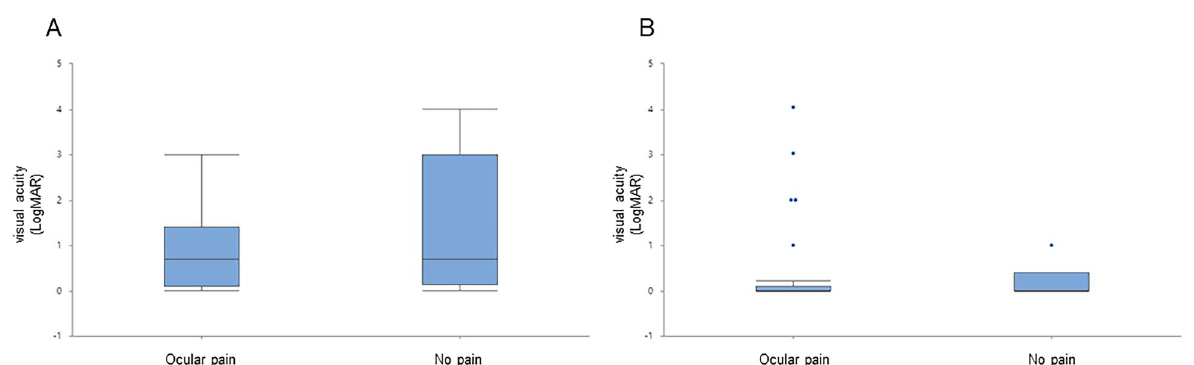
Figure 3. Visual acuity depending on the presence of ocular pain. ( A ) Visual acuity at initial visit (ocular pain group; 0.93 ± 0.13 and normal group; 1.30 ± 0.40) ( p = .282). ( B ) Visual acuity at final follow-up (ocular pain group; 0.26 ± 0.12 and normal group; 0.31 ± 0.11) ( p =